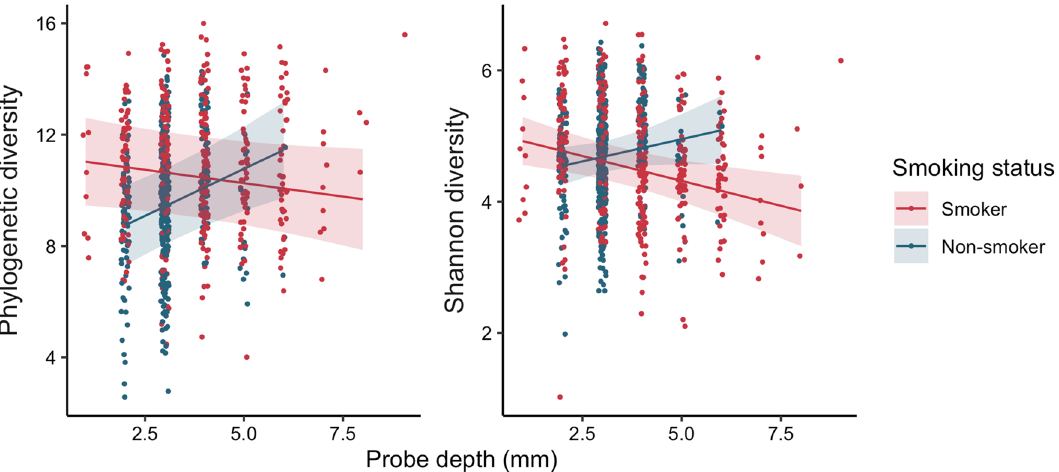
Figure 1. Alpha diversity of subgingival microbiome in smokers and non-smokers according to probing depths. Linear mixed models, which consider the non-independence of samples taken from the same sites and/ or at the same time, of Faith’s phylogenetic diversity (Left) and Shannon diversity (Right) are shown as lines with the shaded region representing 95% confidence band of the mean. Each point represents the alpha diversity of a single sample and the color indicates smoking status (red: smoker; blue: